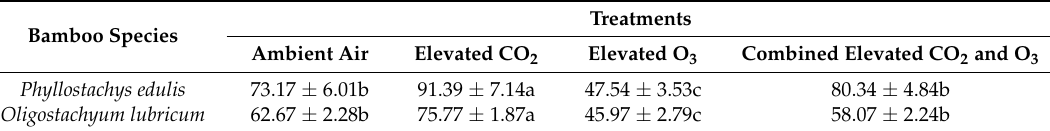
Table 3. The leaf biomass (kg DM) (mean ± s.d., kg DM) of Phyllostachys edulis and Oligostachyum lubricum in response to ambient air, elevated O 3 , CO 2 and combined elevated O 3 and CO 2 . Different letters indicate significant differences among treatments ( p <